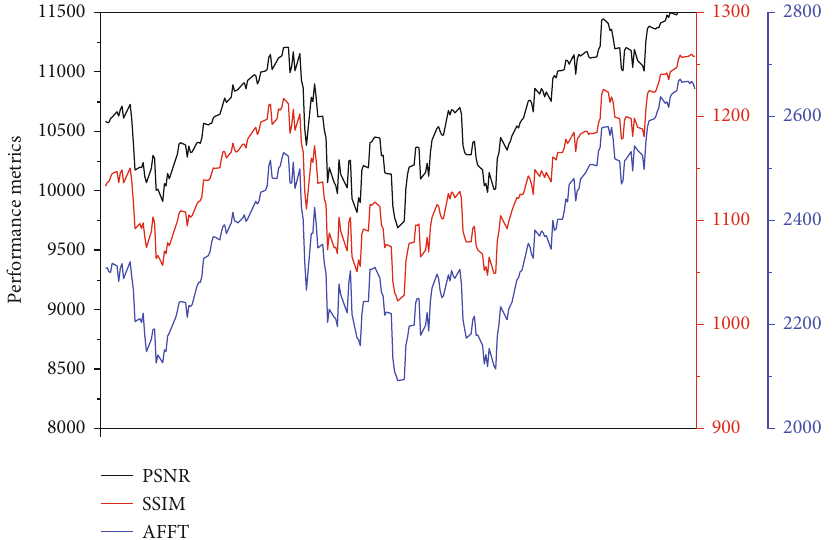
Figure 6: Performance metrics of di ff erent model algorithms for images with di ff erent noise PSNR and